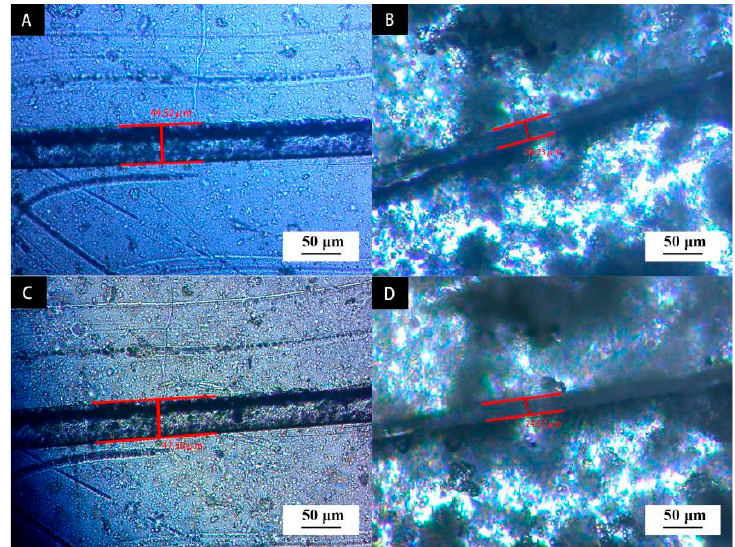
Figure 12. Scratch test of coating: ( A ) microcapsule content 0, scratch first day, ( B ) microcapsule content 6.0%, scratch first day; ( C ) microcapsule content 0, scratch fifth day, ( D ) microcapsule content 6.0%, scratch fifth